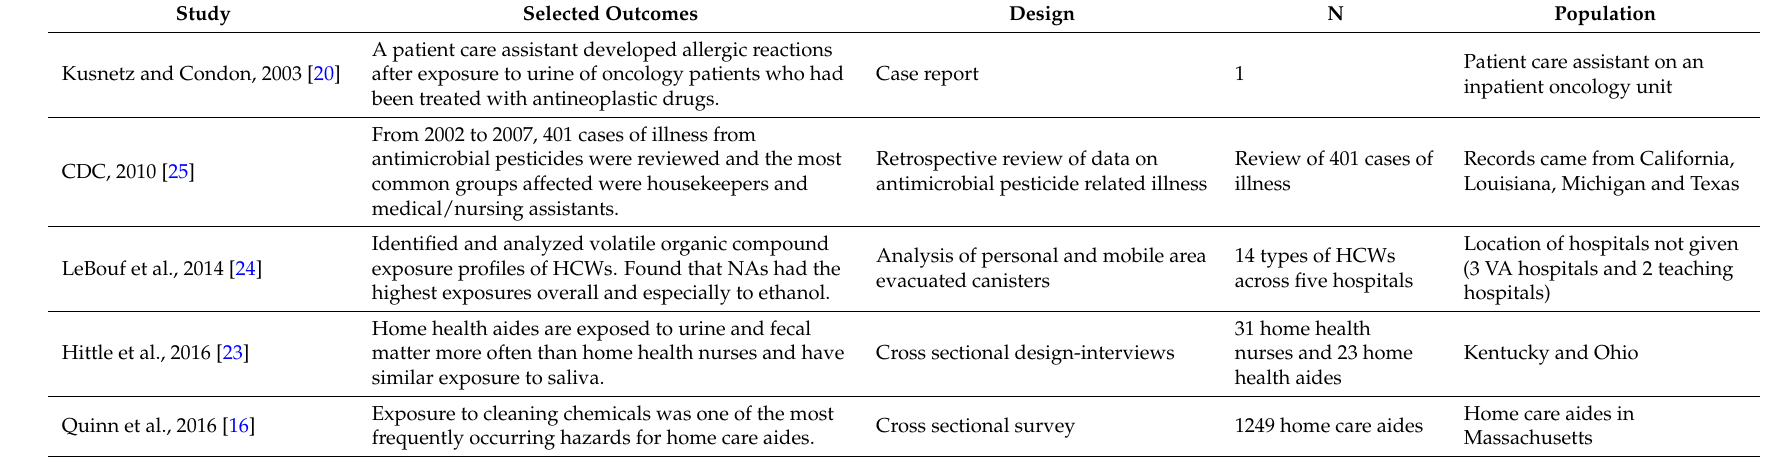
Table 2. Summary of literature reviewed for occupational health and safety hazards to nursing assistants—chemical